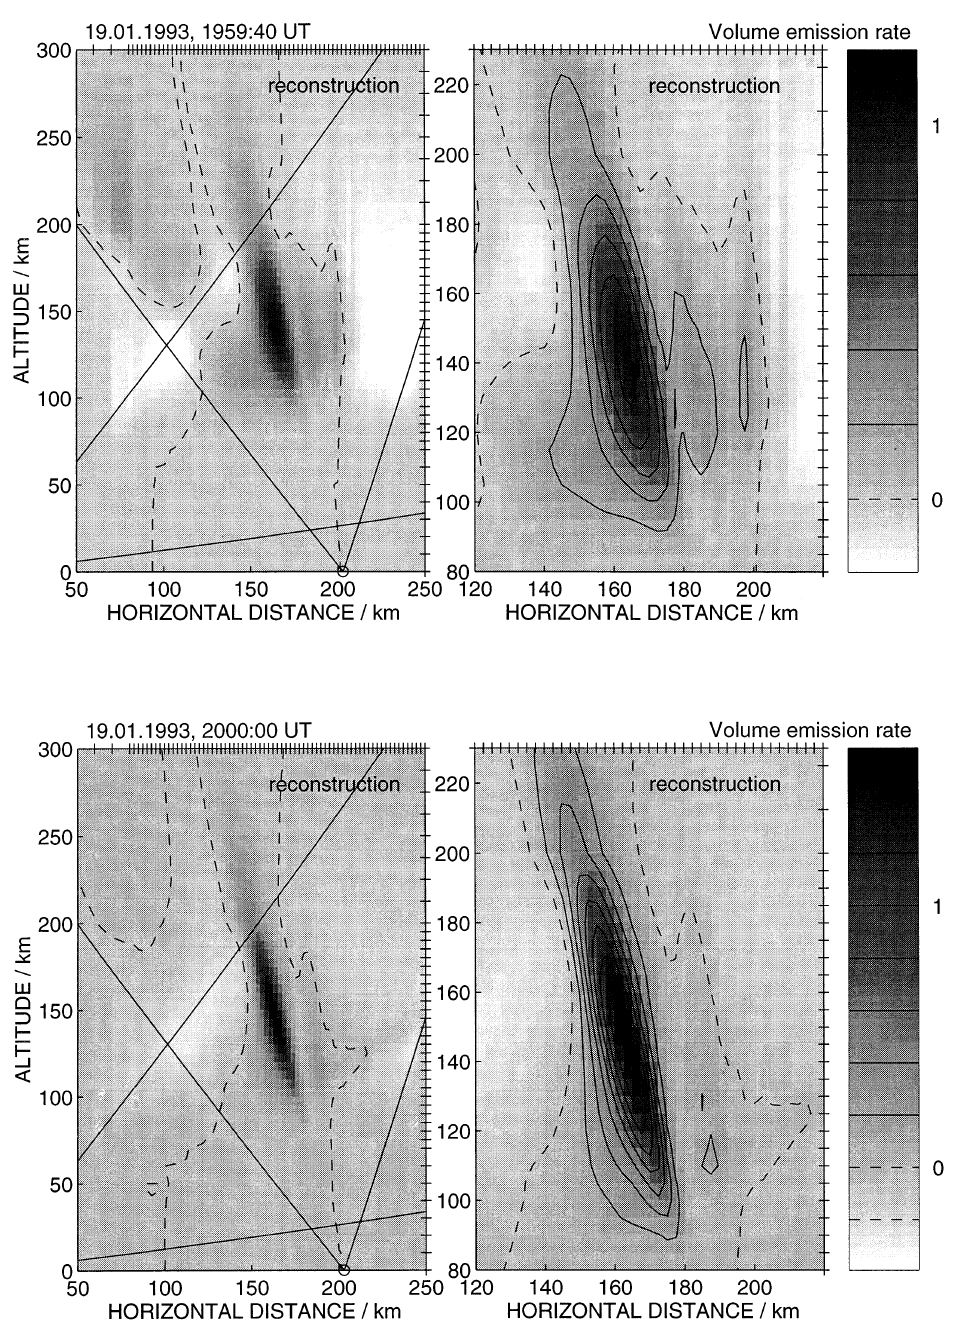
Fig. 10. Same as Fig. 9 at 2000:00